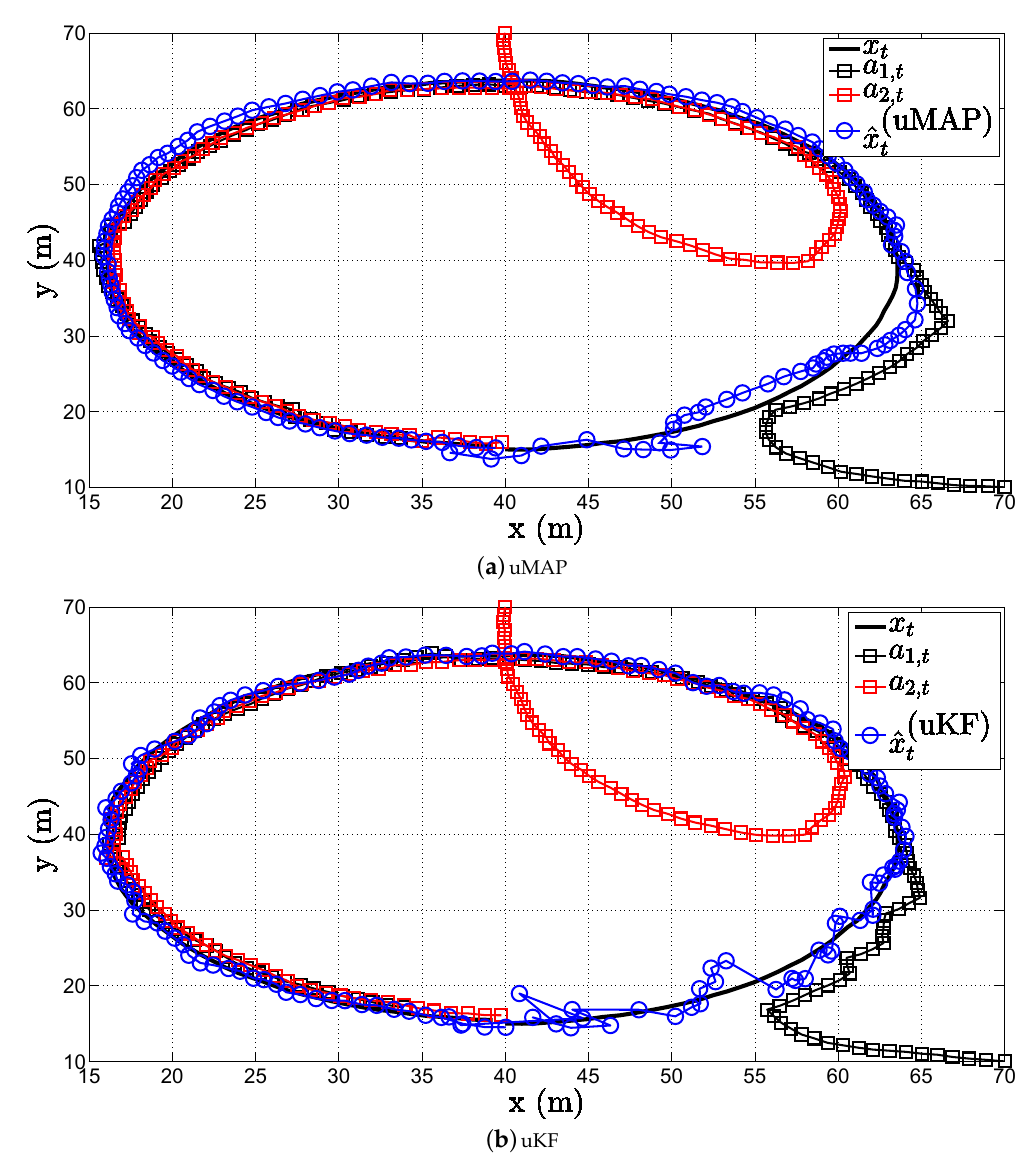
Figure 9. Illustration of the estimation process in the second scenario, when N = 2, (cid:107) v a (cid:107) = 1 m/s, = 9 dB, σ m = 4 π σ n rad, γ = 3, γ i ∼ U [ 2.7,3.3 ] , τ = 5 m, P 0 = − 10 dBm, q = 2.5 × 10 − 3 m 2 /s 3 180 i i